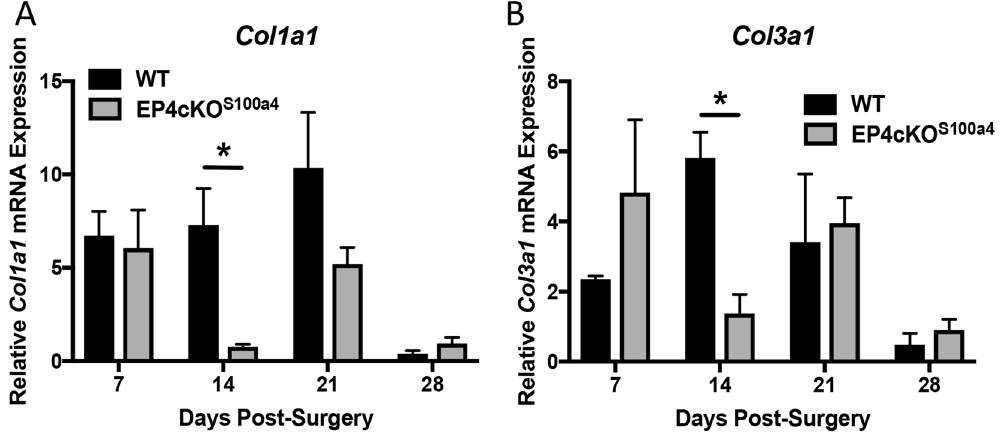
Figure 5. EP4cKO S100a4 repairs heal with decreased expression of Col1a1 and Col3a1 . mRNA was isolated from EP4cKO S100a4 and WT mice between 7–28 days post-surgery. A significant decrease in both ( A ) Col1a1 , and ( B ) Col3a1 expression was observed at day 14 post-surgery in EP4cKO S100a4 relative to WT. Expression was normalized to the internal control β -actin . ( * ) Indicates p <